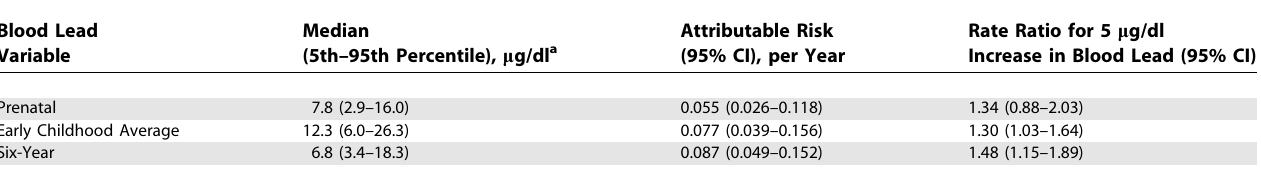
Estimates adjusted for maternal IQ, sex, SES using the Hollingshead Score, and maternal education level. a To convert blood lead to l mol/l multiply by 0.04826.